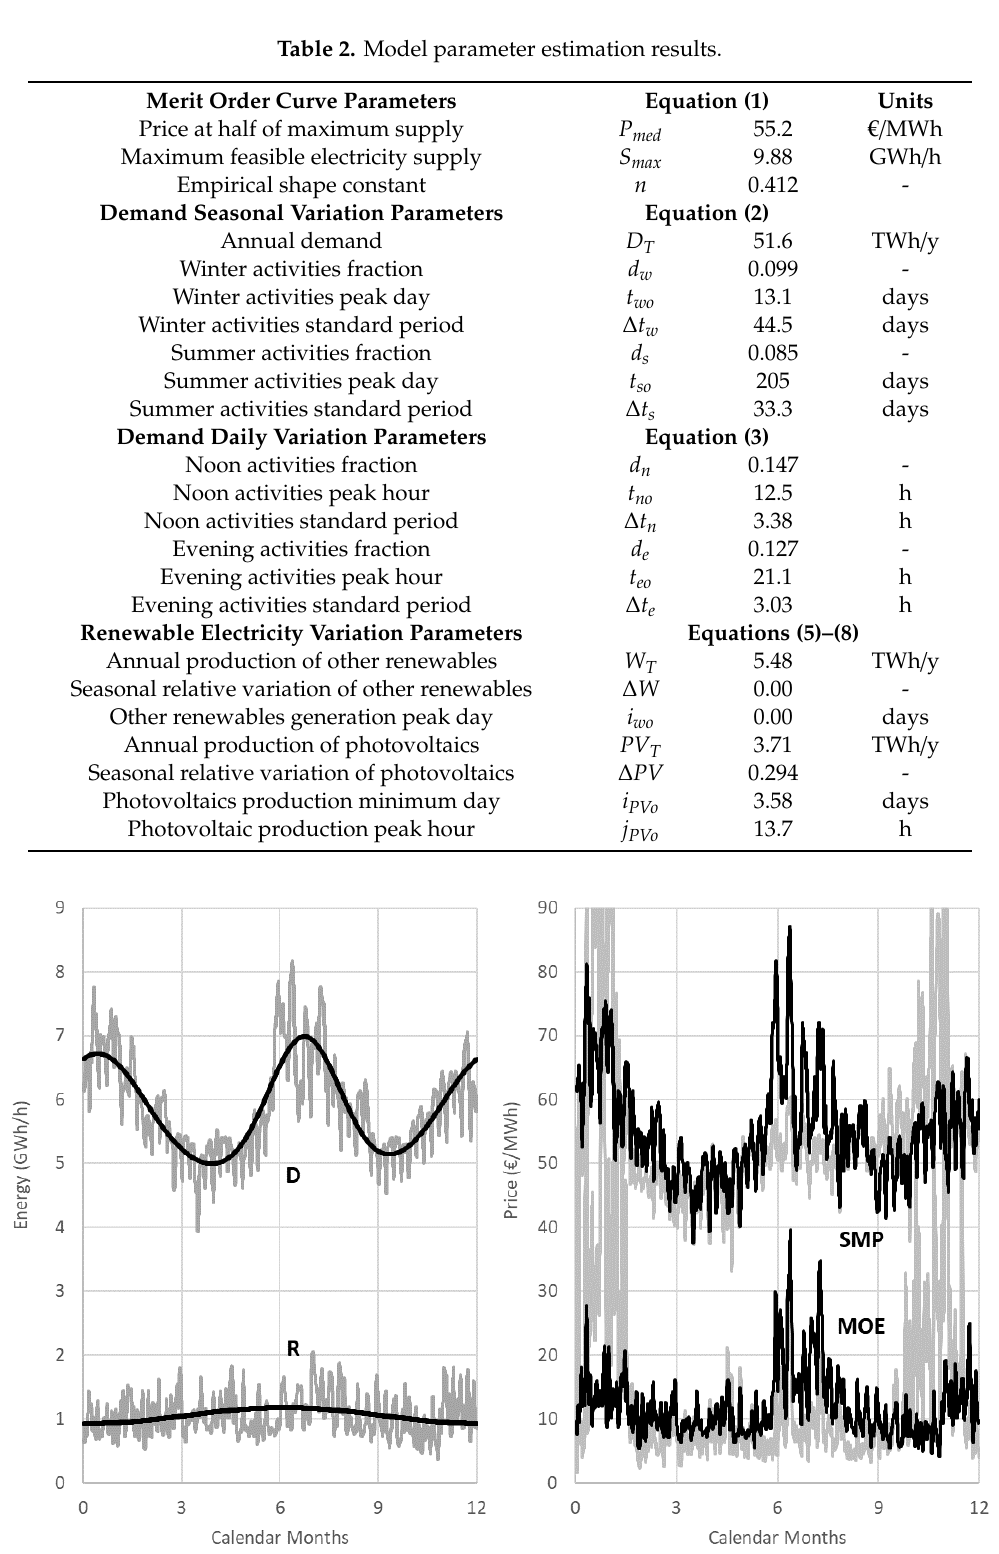
Figure 9. Daily variation: Comparison between real (points) and model calculated (lines) values. D = demand, DR = demand renewables, R = renewables, VSMP = virtual system marginal price, SMP = system marginal price, MOE = merit order effect.